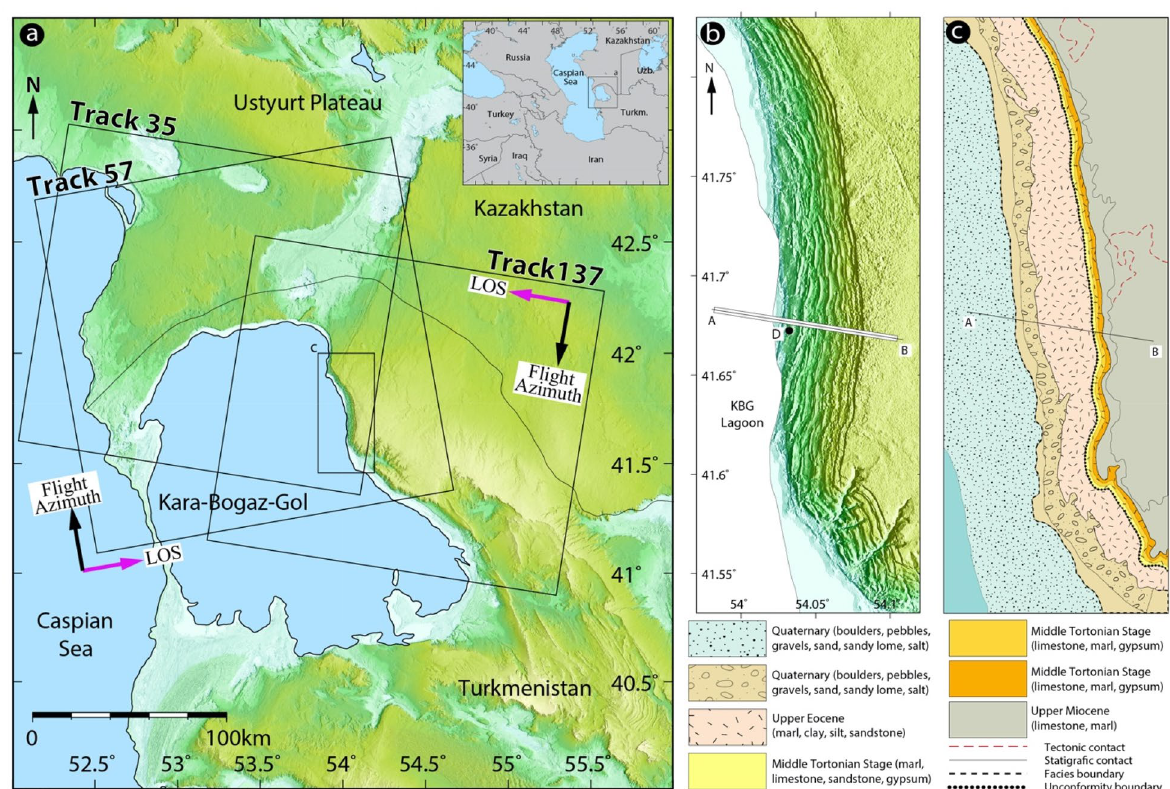
Figure 1. SAR data coverage and geological map of the study area. ( a ) Map showing the location of the study area. The inset map shows the location of the CS in relation to Asia Minor and Central Asia. Sentinel 1-A/B SAR data coverage is overlain on the 30 m shaded topography (ALOS (AW3D30) DEM data). Rectangles labelled with track numbers (Ascending tracks 57 and descending tracks 35 and 137) indicate the coverage of the IW SAR images. Magenta and black arrows indicate the satellite’s LOS look and flight directions, respectively, and the black rectangle indicates the selected study area. ( b ) Topographic view of the eastern bank of the KBG lagoon including the stepped topography caused by lateral spreading of the plateau toward the lagoon. ( c ) Schematic geological map and lithological descriptions taken from the OneGeology Platform (http:// www. onege ology. org); the A–B profile along the landslide path is shown in Fig. 5. This figure was created with Adobe Illustrator CS6 ver. 16 (http:// www. adobe. com/ produ cts/ illus trator.